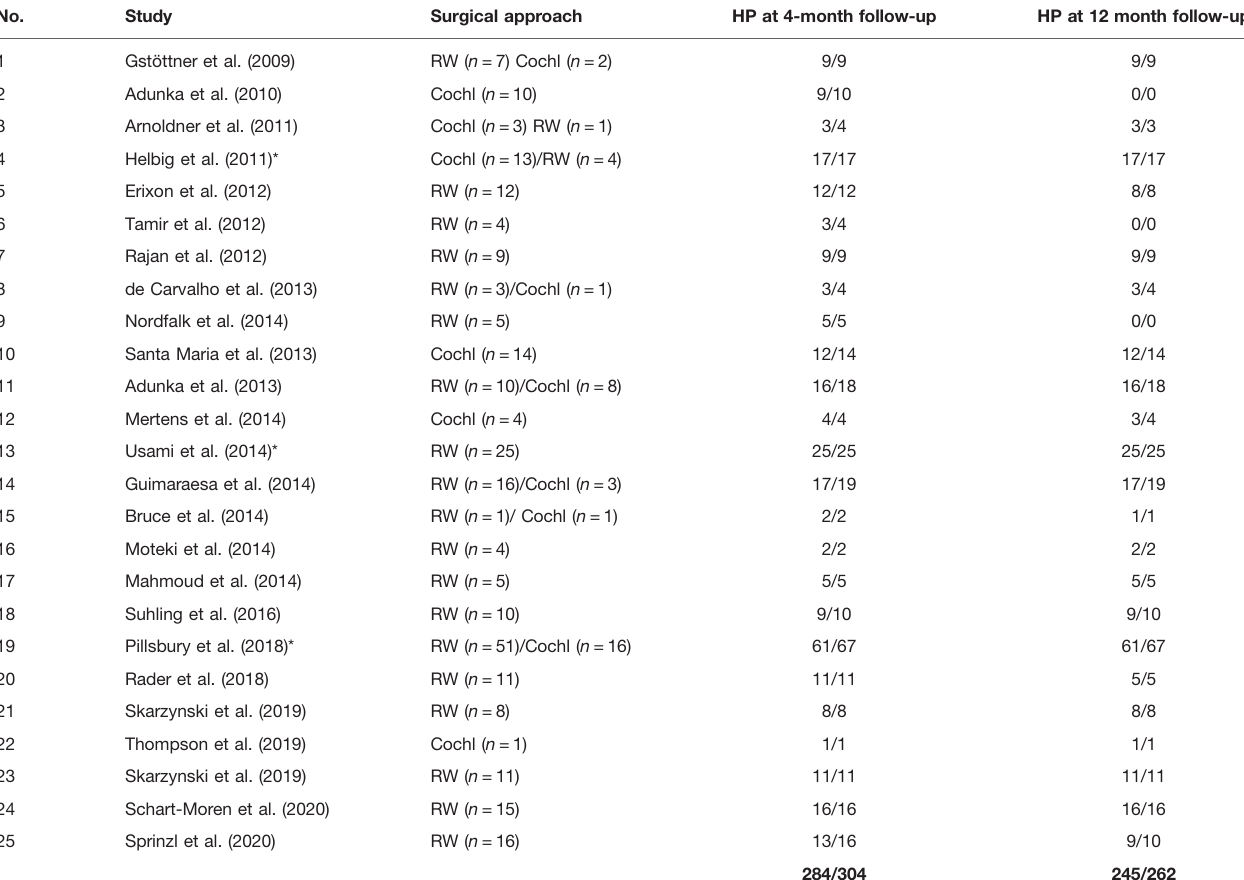
TABLE 2 | Studies that reported on the number of HP patients implanted with FLEX24 electrodes